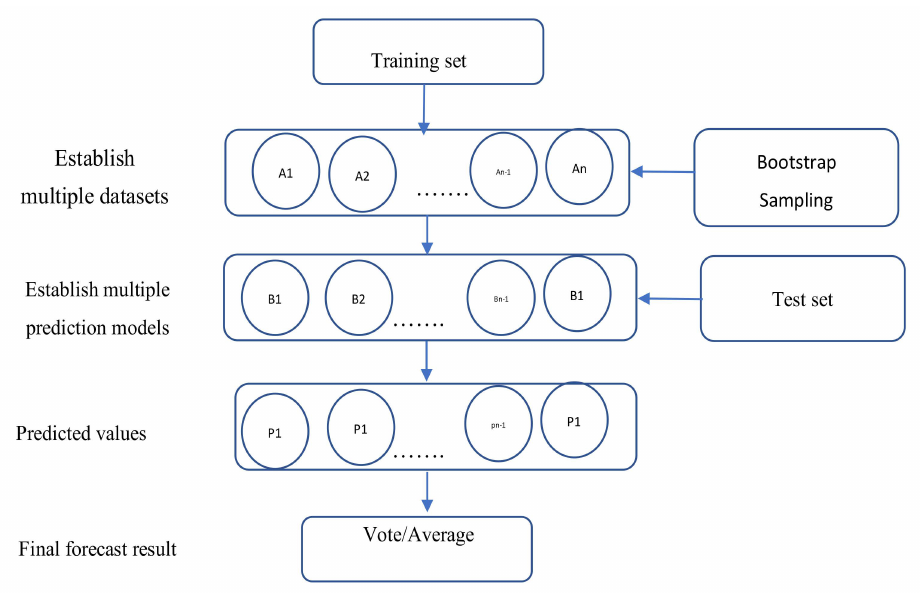
Figure 2. Schematic diagram of the bagging